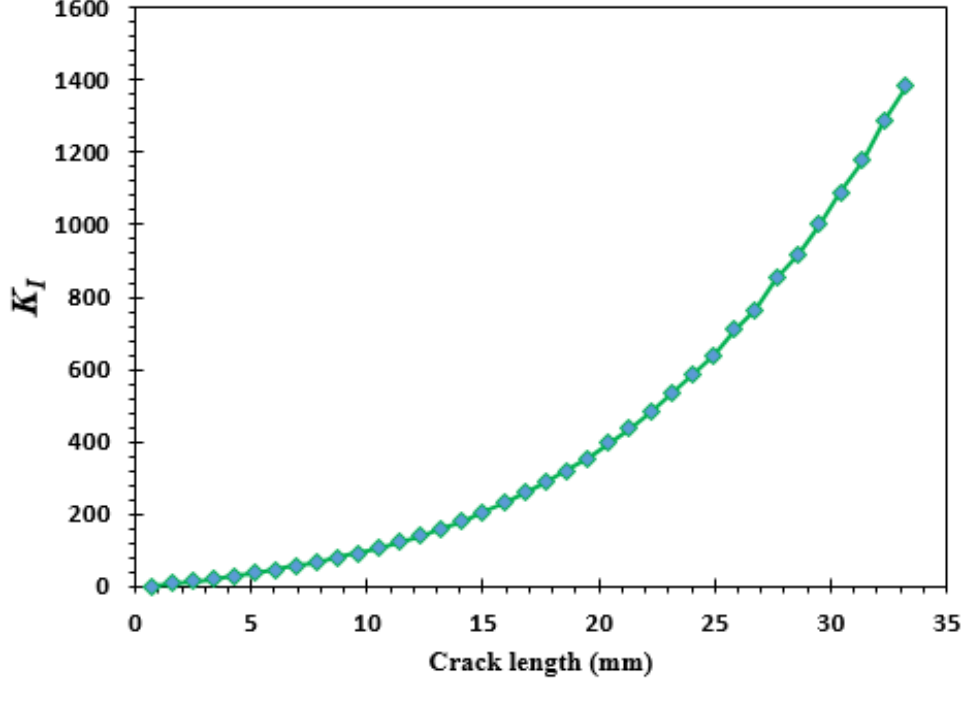
Figure 15. Predicted values of the first mode of stress intensity factors.